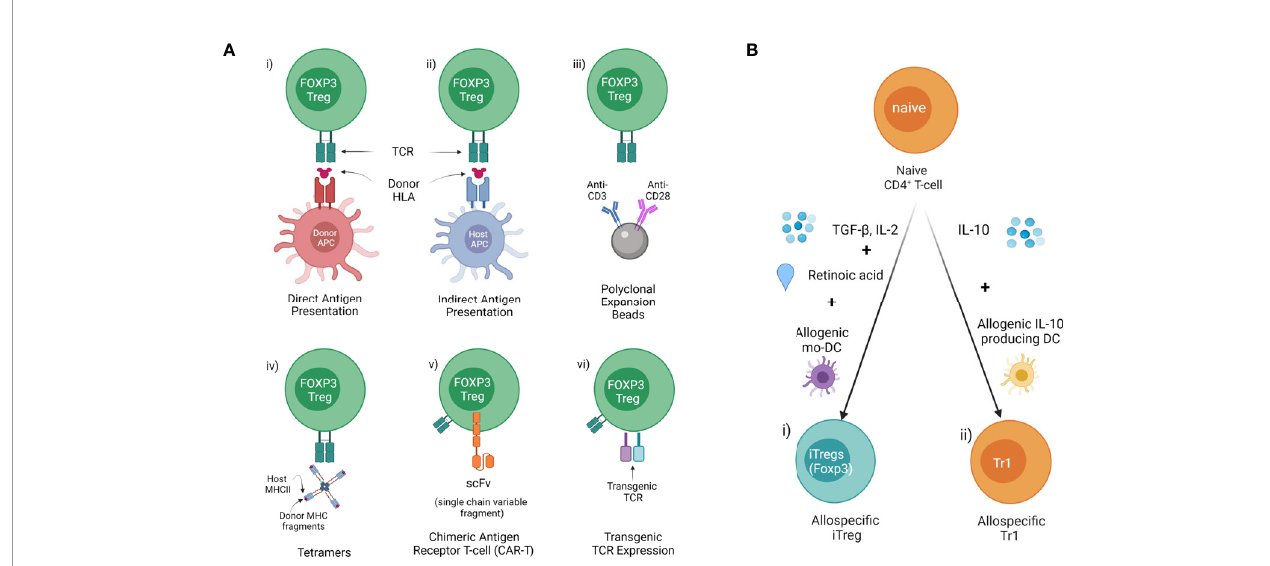
FIGURE 2 | Methods of allospeci fi c Treg derivation (A) Generating donor antigen-speci fi c Tregs from FOXP3 + Tregs (CD4 + CD25 + CD127 - ) precursors. This includes donor HLA presented to generate i) direct antigen expanded (donor APC/MHCII) or ii) indirect antigen expanded Tregs ed (host APC/MHCII). iii) Polyclonal expansion with antiCD3/CD28 beads. iv) Isolation of speci fi c Tregs using Tetramers composed of host class II MHC & donor MHC fragments. v) Insertion of antibody fragment scFv connected to TCR to create a CAR. vi) Genetic modi fi cation of Tregs with transgenic TCR. (B) Inducing donor antigen-speci fi c i) iTreg and ii) Tr1 from naïve CD4 + T